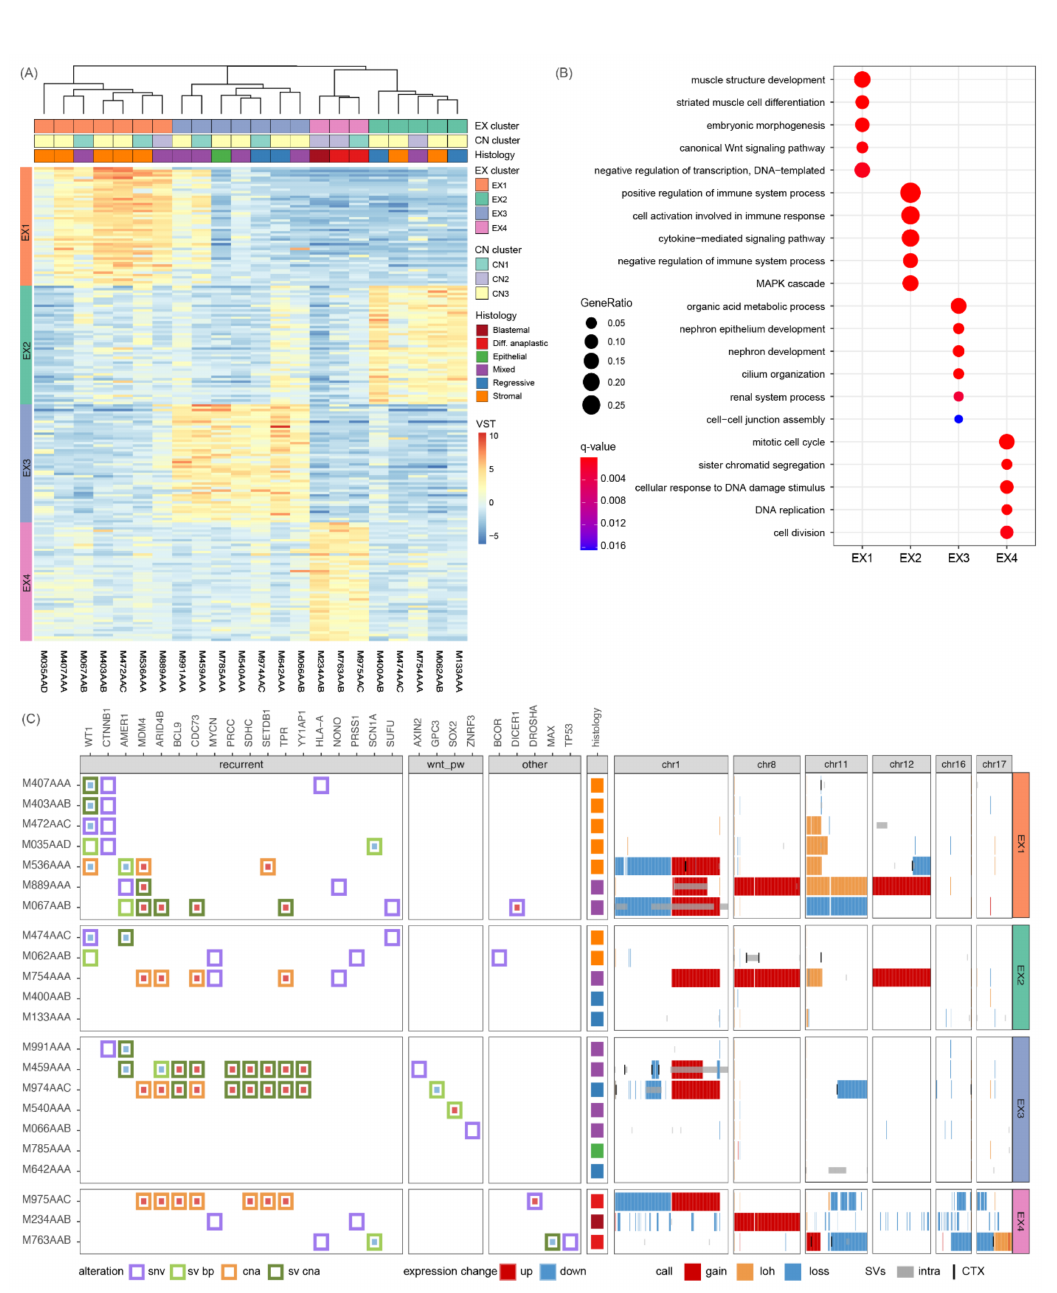
Figure 2. Gene expression data groups tumors with diverse genetic alterations that affect similar biological processes. Tumors were clustered in four groups (EX1–EX4) based on their resemblance to the four expression profiles identified by unsupervised analysis of the 10,000 most variably expressed genes (see methods). ( A ) Tumors (columns) of each expression cluster show upregulation of the genes (rows) of the corresponding expression profile compared to tumors of other expression clusters. Shown are the top 50 genes of each expression profile sorted by log2-fold change (l2fc). Tumors are annotated by their histological subtype. ( B ) Representative biological processes enriched in expression profiles (q-value < 0.05). ( C ) Oncoplot of tumors grouped by their expression cluster with alterations (left) and CN profiles with SVs (right), similar to Figure 1. The Oncoplot displays alterations affecting recurrently altered cancer genes, Wnt pathway genes and WT associated genes from Treger et. al. (2019) [7]. Alteration types: SNVs (purple) and SV breakpoints (light green), as well as nearby or overlapping SVs (dark green) and CNs (orange) in case of a gene expression change (nz-score >+/ − 1.98). The CNs and SVs are displayed for recurrently altered chromosomes 1, 8, 11, 12, 16 and 17, depicted as in Figure 1B. See Table S5 for gene alteration data and Figures S5 and S6 for full sized